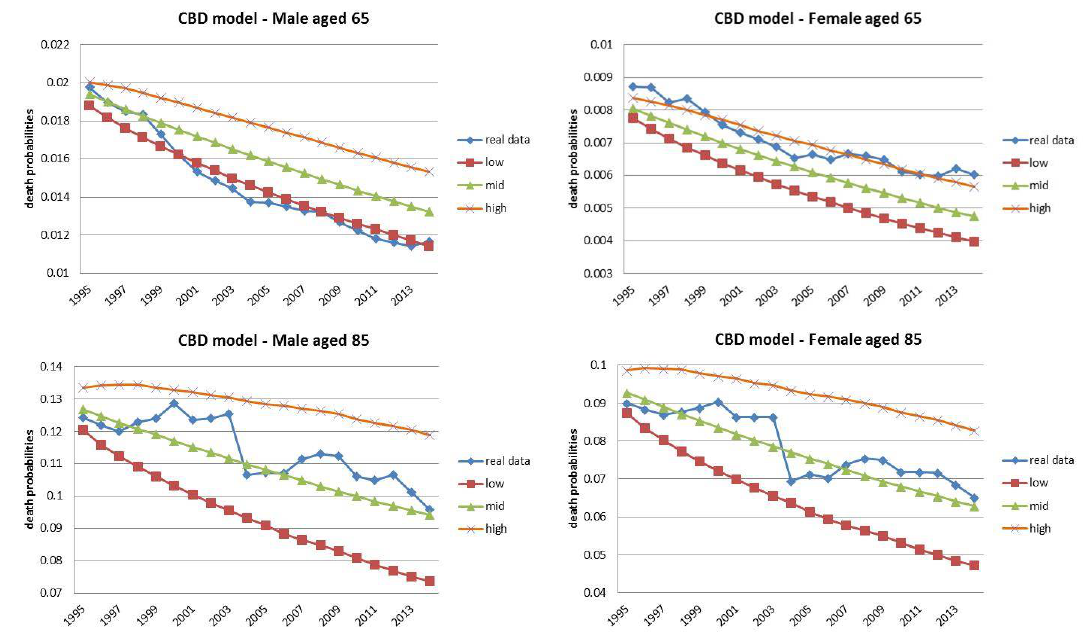
Figure 9. CBD Fixed Horizon Backtest forecast: comparison between observed death rates and the corresponding 95% confidence interval of the forecast based on the time series 1975–1994.